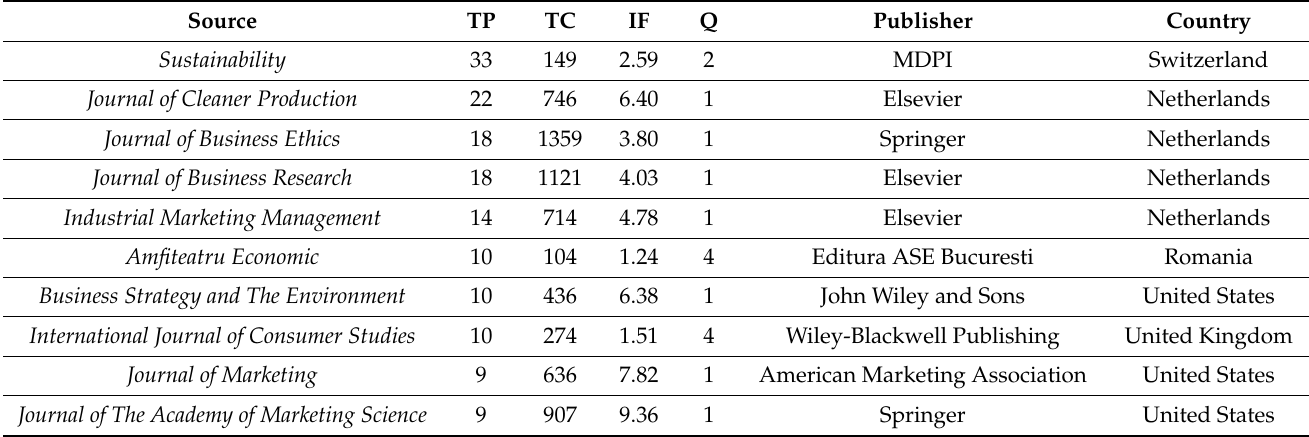
Table 4. Source Impact.